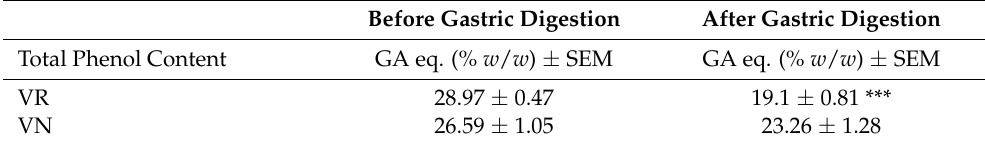
Table 2. Total phenolic content (wt.% GA eq./wt.% d.e.) of extracts from Castanea sativa Mill. leaves. Before Gastric